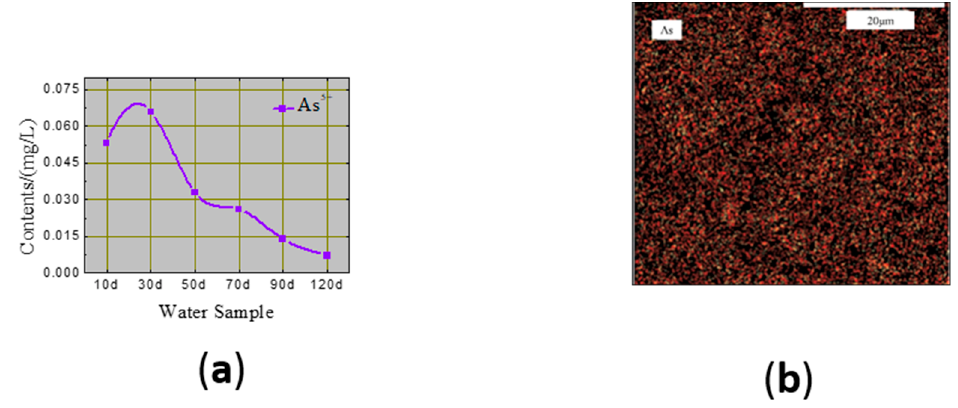
Figure 9. ( a ) As 5+ concentration in leachate and ( b ) corresponding micro-morphology , determined by X-ray X-ray imaging.